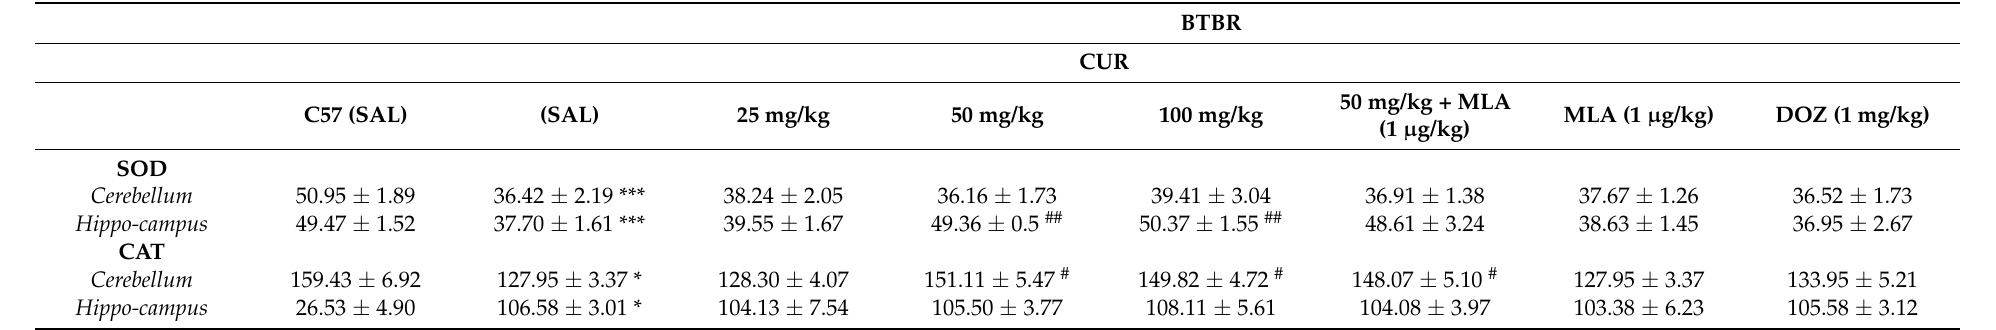
Table 2. Curcumin and donepezil mitigated levels of oxidative stress markers in the cerebellum and the hippocampus of treated BTBR